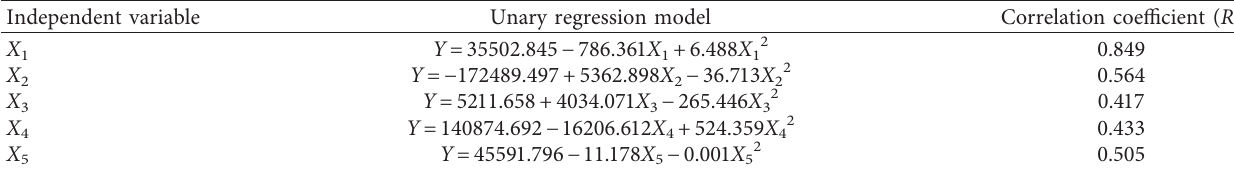
Table 2: Unary regression model and coefficients.